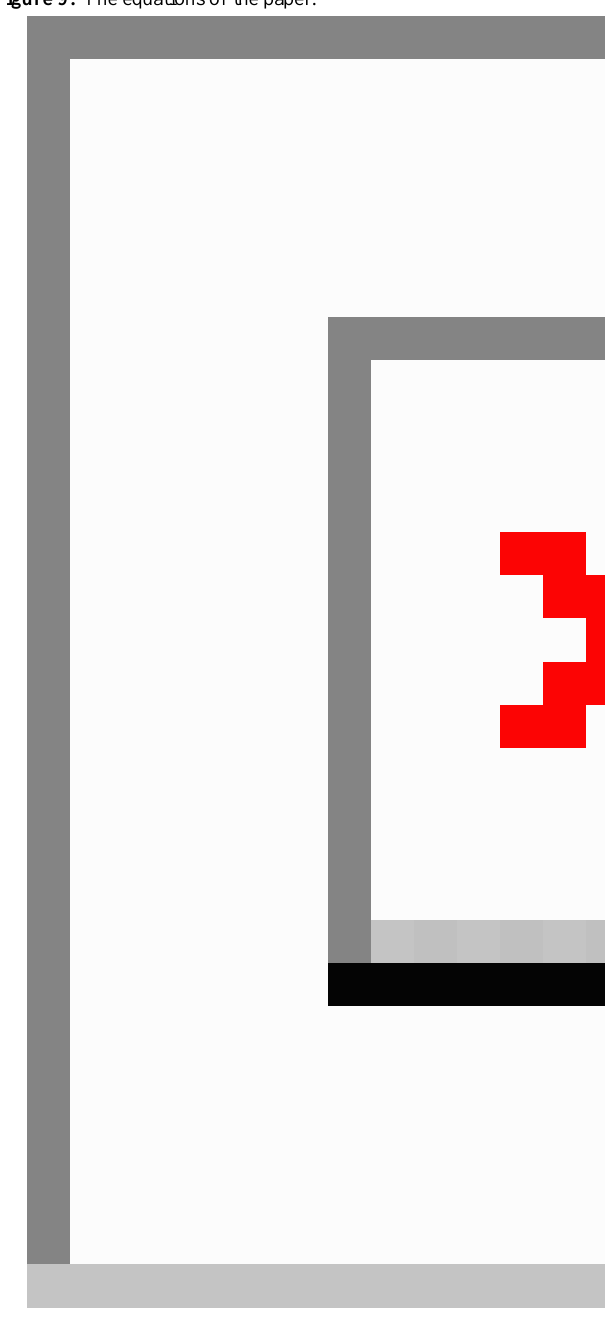
Figure 9. The equations of the paper.